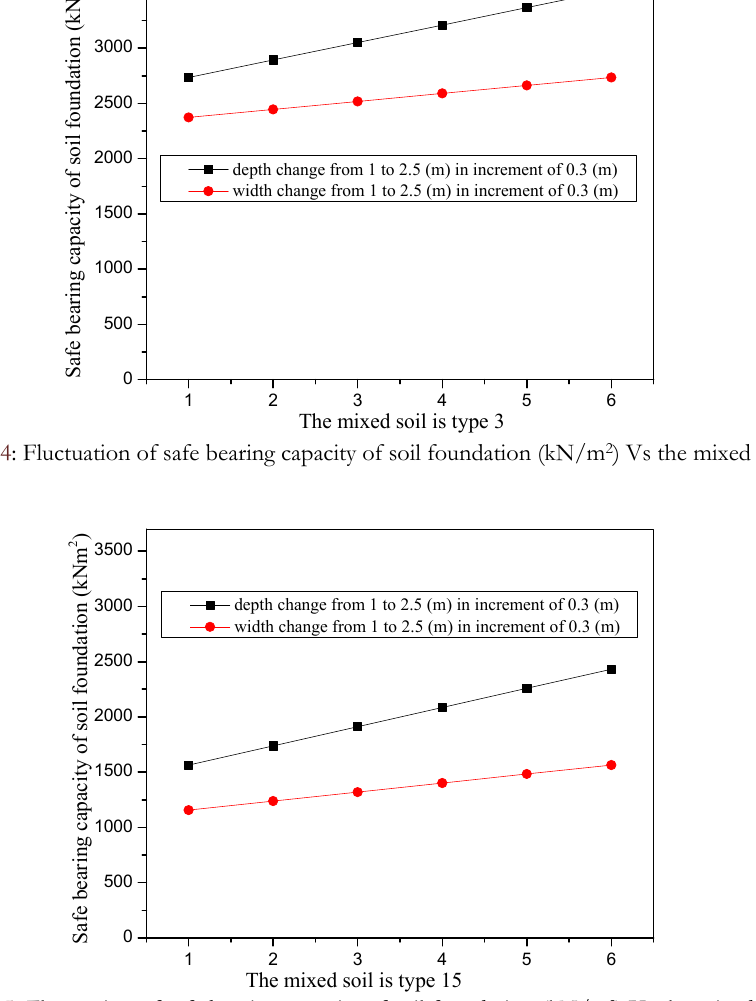
Figure 5: Fluctuation of safe bearing capacity of soil foundation (kN/m 2 ) Vs the mixed soil